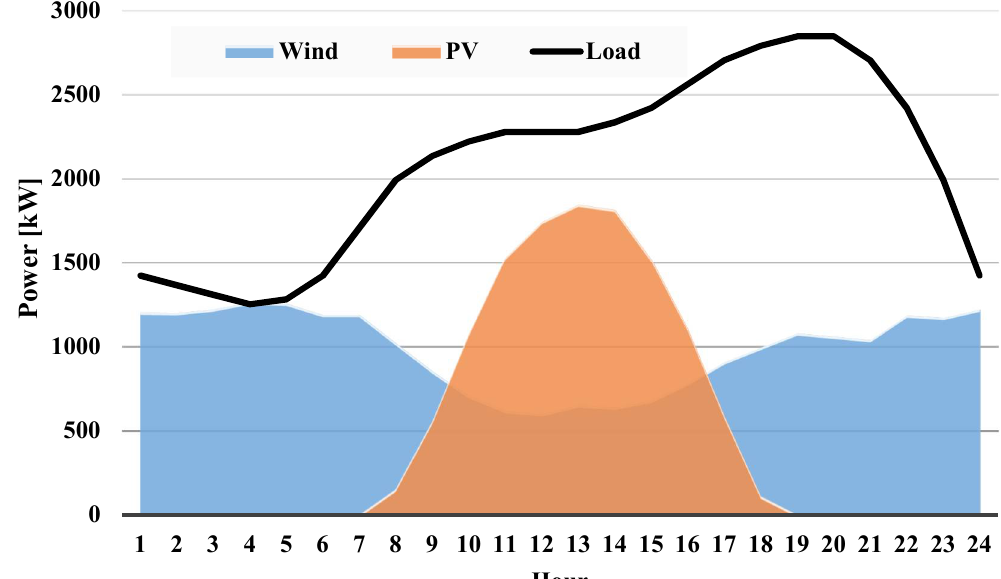
Figure 4. Hourly power generation for wind and PV resources.